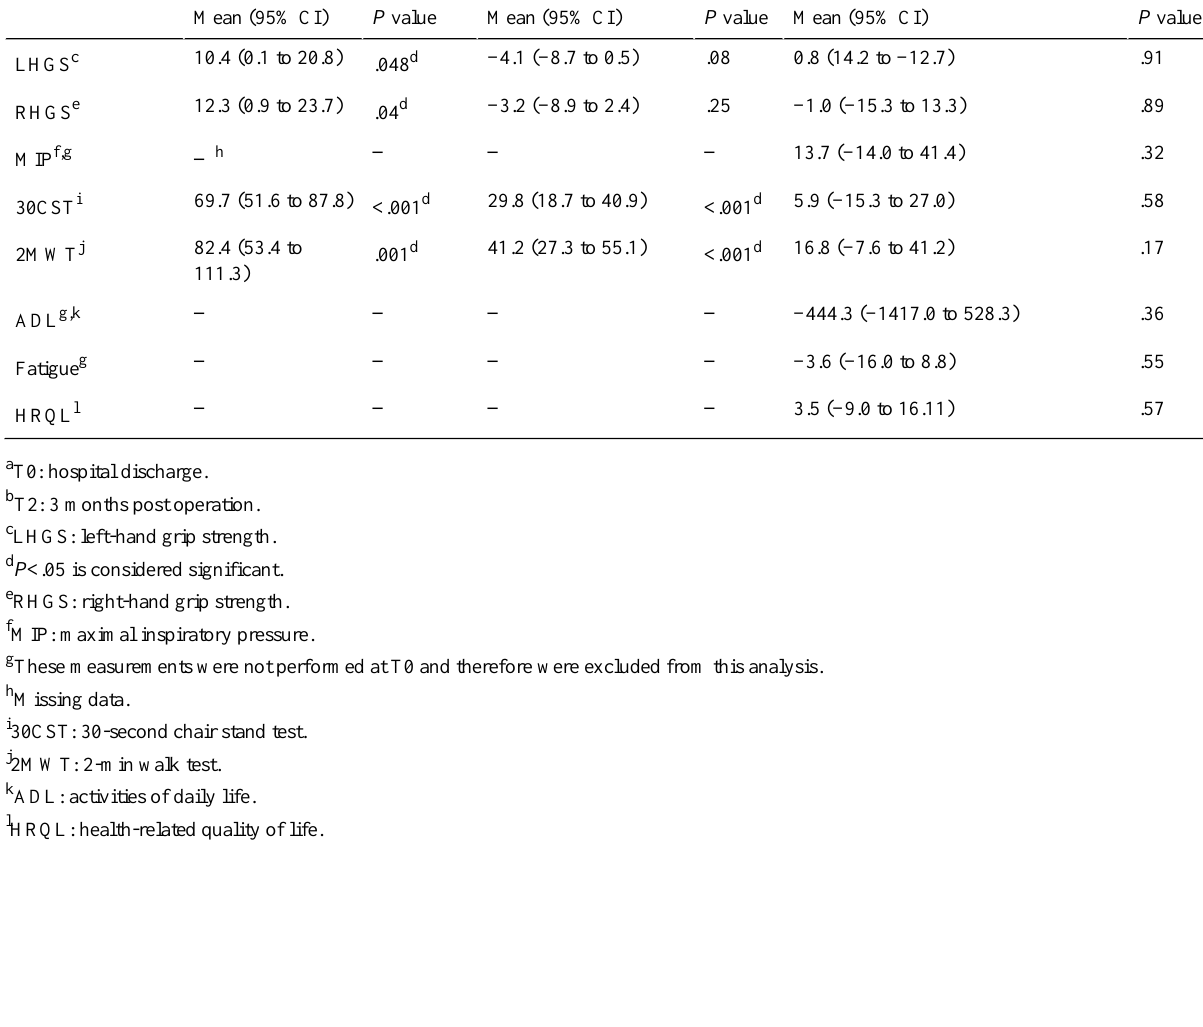
Between-group differences at T2Within-group differences (T0-T2) a,b Functional status